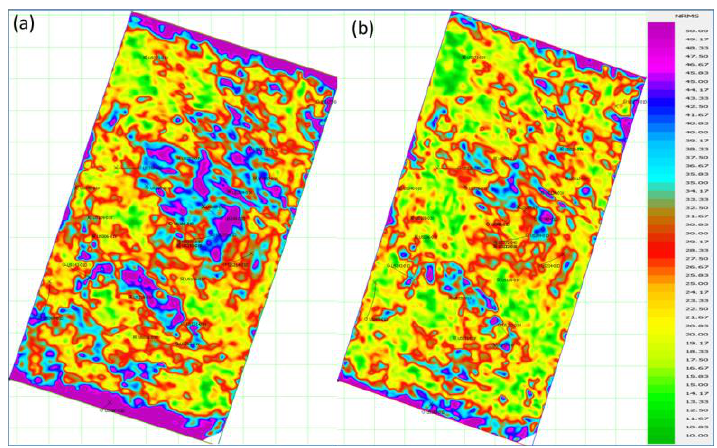
Figure 6. Horizon slice of reservoir level: ( a ) NRMS of KPSDM seismic volume, and ( b ) NRMS of LSM seismic volume.